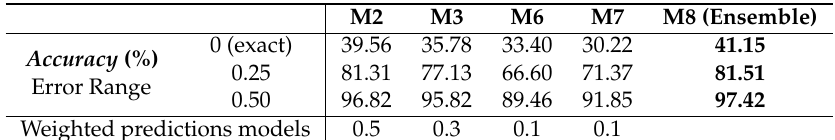
Table 6. Model ensembling: accuracy of models and associated weights to individual predictions. Best results are in bold.